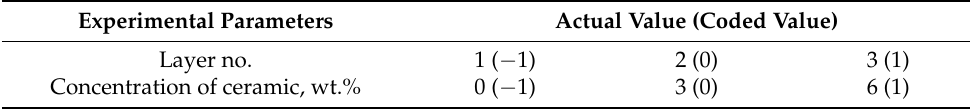
Table 1. Levels of experimental design and range of independent